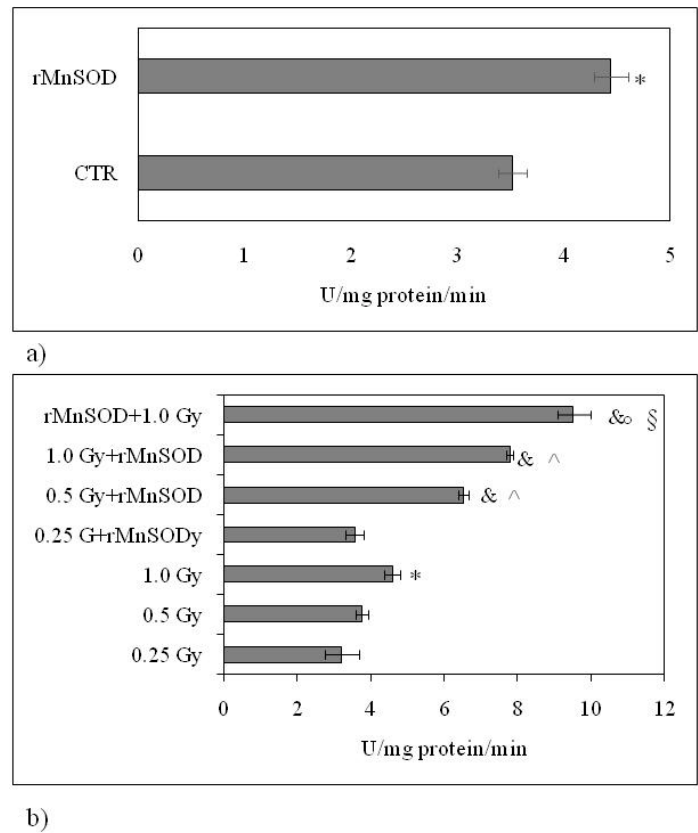
Figure 4. Activity of nSMase. Significance: ( a ) not-irradiated rMnSOD-treated samples compared to not-irradiated and not-rMnSOD-treated samples (CRT) (* p < 0.05); ( b ) irradiated not-rMnSOD-treated samples and irradiated rMnSOD-treated and pretreated samples. Significance: irradiated samples compared to CTR samples (* p < 0.05), irradiated and rMnSOD-treated and pretreated samples vs. rMnSOD-treated samples (& p < 0.05), irradiated and rMnSOD-treated samples vs. their correspondent irradiated samples (ˆ p < 0.05), rMnSOD pretreated and 1.0 Gy irradiated sample vs. 1.0 Gy irradiated sample ( ◦ p < 0.05), rMnSOD pretreated and 1.0 Gy irradiated sample vs. 1.0 Gy irradiated and rMnSOD-treated sample (§ p < 0.05).